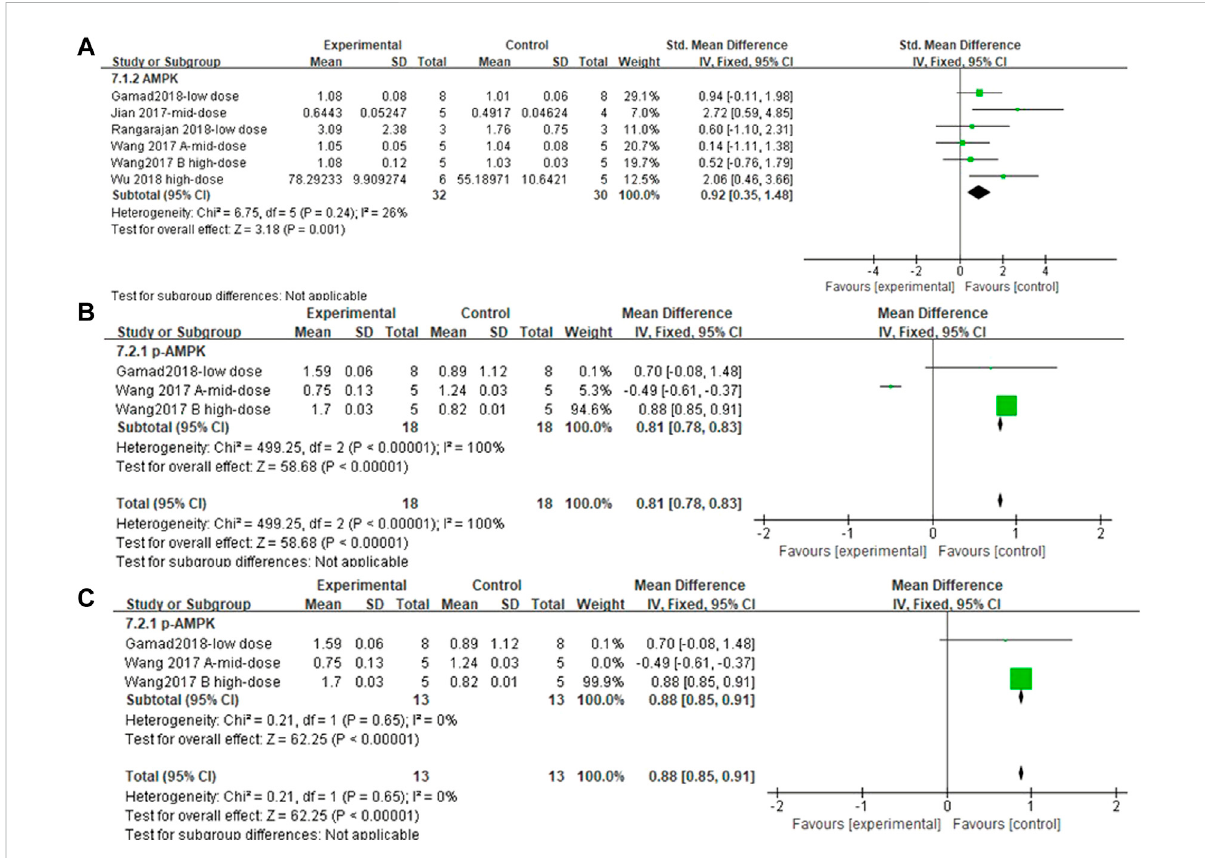
FIGURE 11 Effect of MET on AMPK/p-AMPK. (A) Forest plot of AMPK; (B) Forest plot of p-AMPK; (C) Forest plot of p-AMPK [after removing Wang Y. et al.,